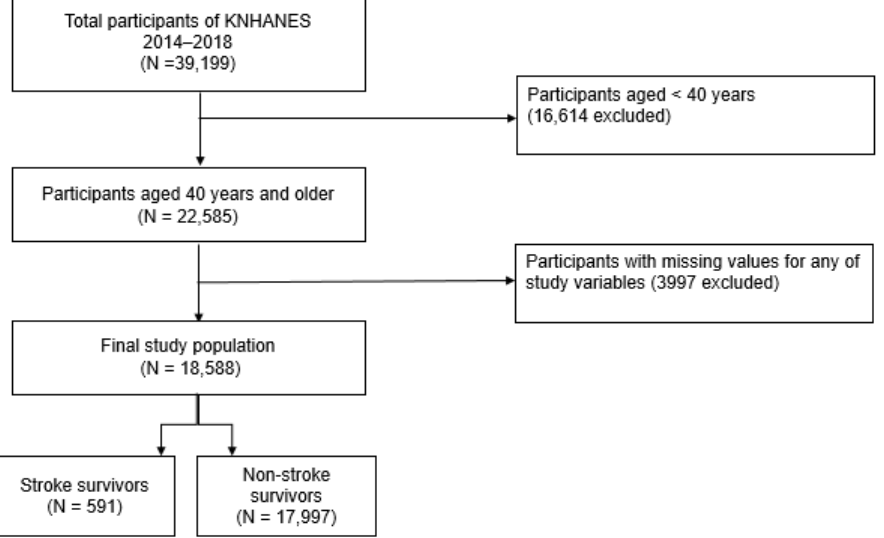
Figure 1. Flow diagram of selection of study population. KNHANES, Korea National Health and Nutrition Examination Survey.